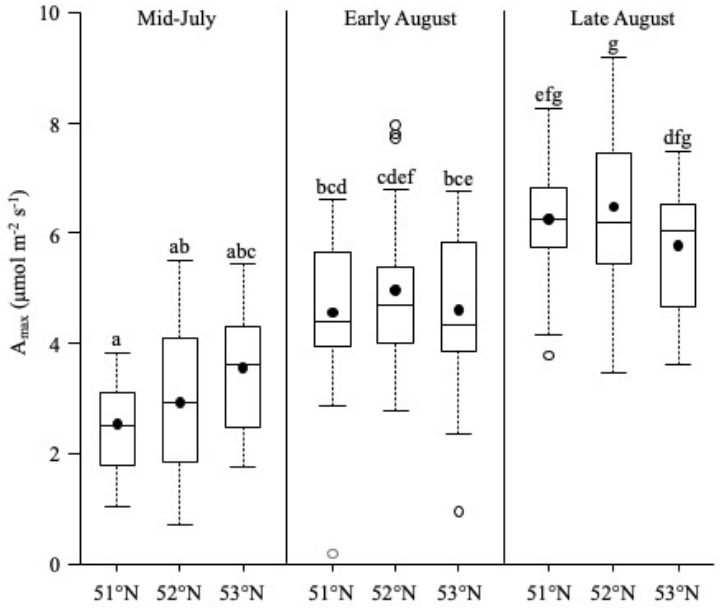
Figure 6. Interaction between A max values for latitude and time in the growing season. Solid points represent the mean and letters represent significant differences at the 5% level between latitude and time of growing season (Tukey test).